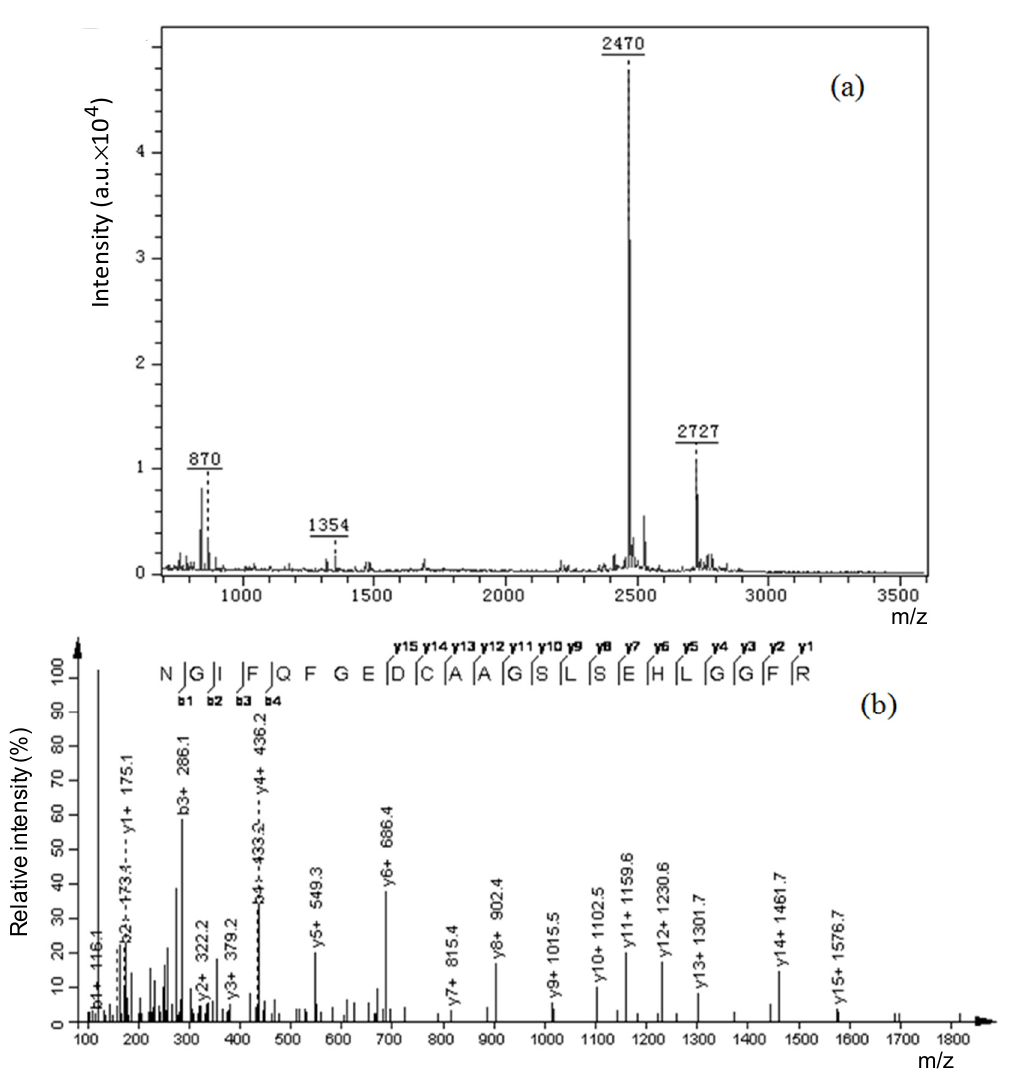
Figure 3. A peptide sequence from trypsin-digested Cs-GP1 detected by MALDI-TOF-MS/MS: ( a ) Spectrum of the peptide sequence; ( b ) Spectrum of its fragment with m / z at